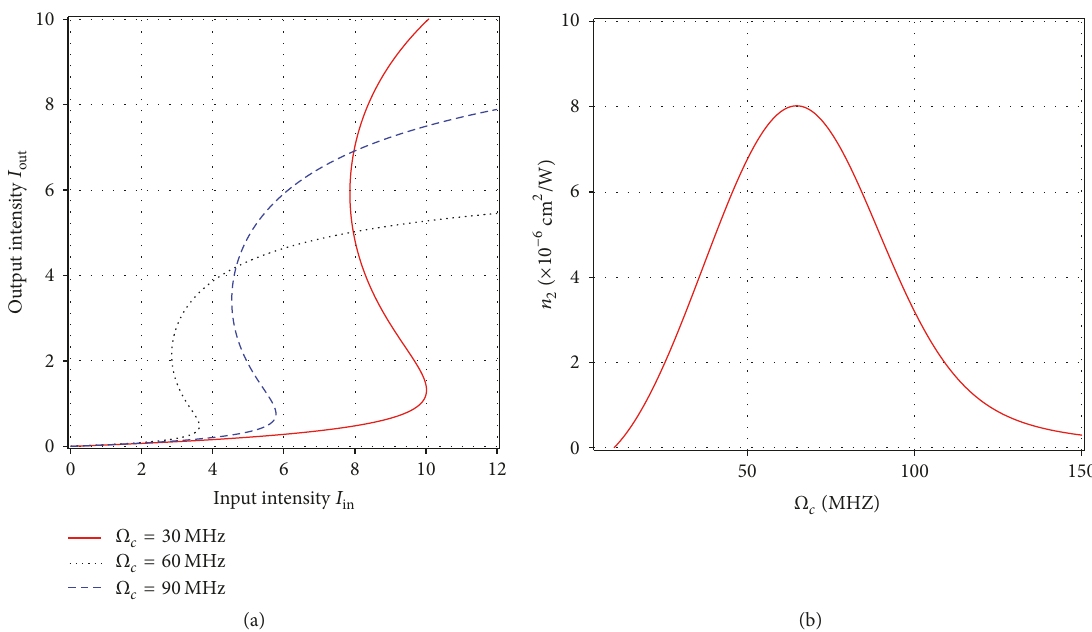
Figure4:OBcurvesatparticularvaluesofintensityofthecouplingfield(a)andvariationofKerrcoefficient 𝑛 2 versusintensityofthecoupling field (b). The parameters are Δ 𝑝 = −5 MHz, Δ 𝑐 = 0 , and 𝑇 = 300